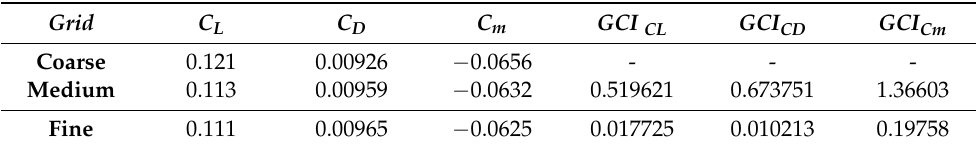
Table 1. Aerodynamic coefficients for the three grids used in the convergence study ( α = 2 ◦ , M = 0.9, Re = 10 × 10 6 ). Grid C L C D C m GCI CL GCI CD